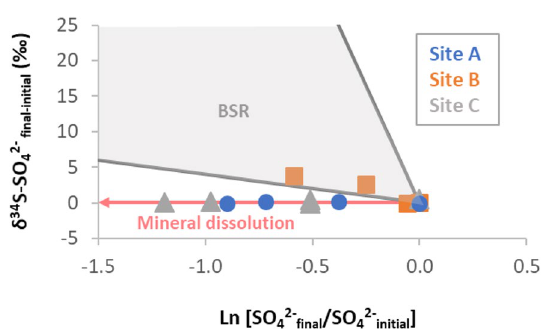
Figure 5. Sulphur cycling processes revealed by isotopic data. Theoretical trends for SO 4 2− minerals/salts dissolution and BSR have been drawn by using ε = 0‰ and from − 4 to − 66‰, respectively. These lines are plotted together with the obtained results for our samples. For both axes, “final” corresponds to the values obtained at each depth while “initial” correspond to the deepest points (highest SO 4 2−